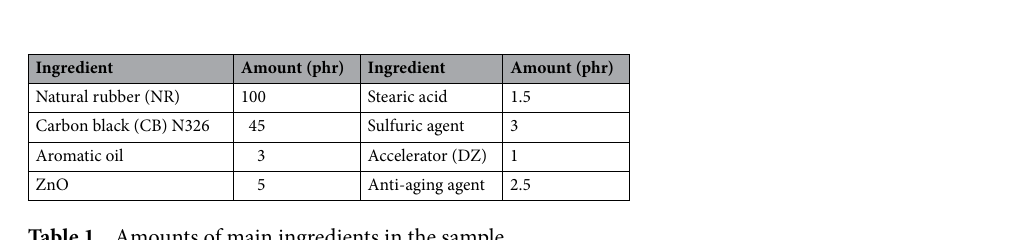
Table 1. Amounts of main ingredients in the